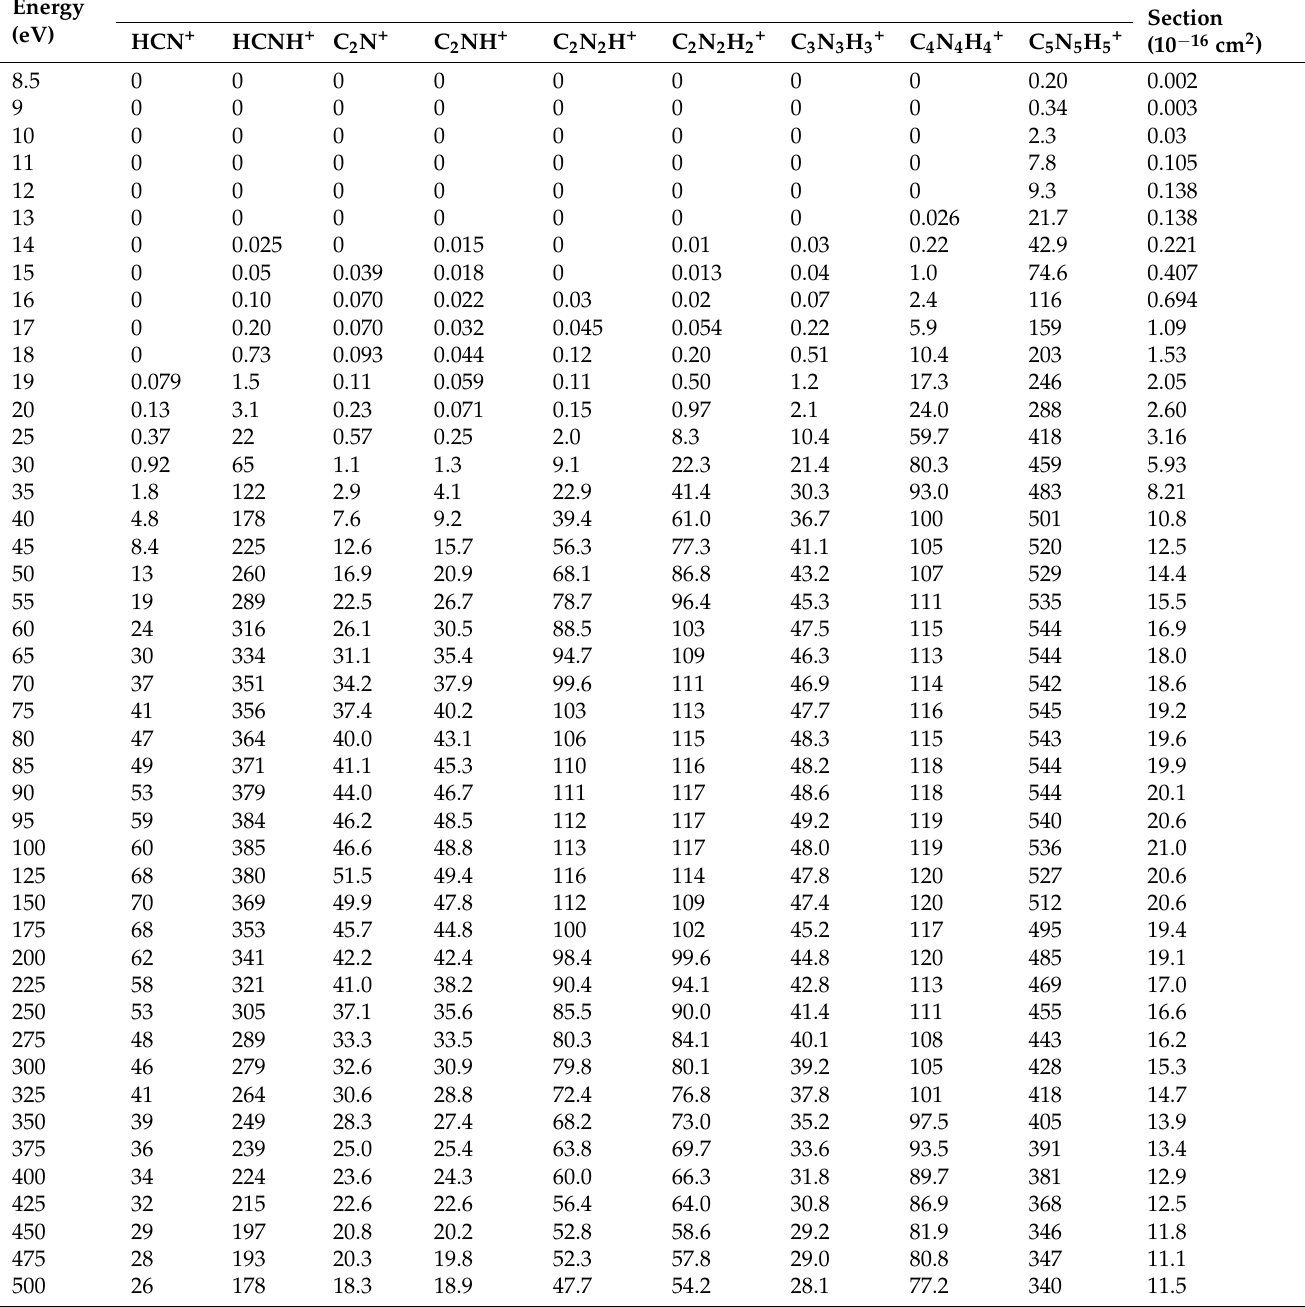
Table 3. Partial ionization cross sections for prominent ions and the total ion cross section obtained by summing all the partial cross